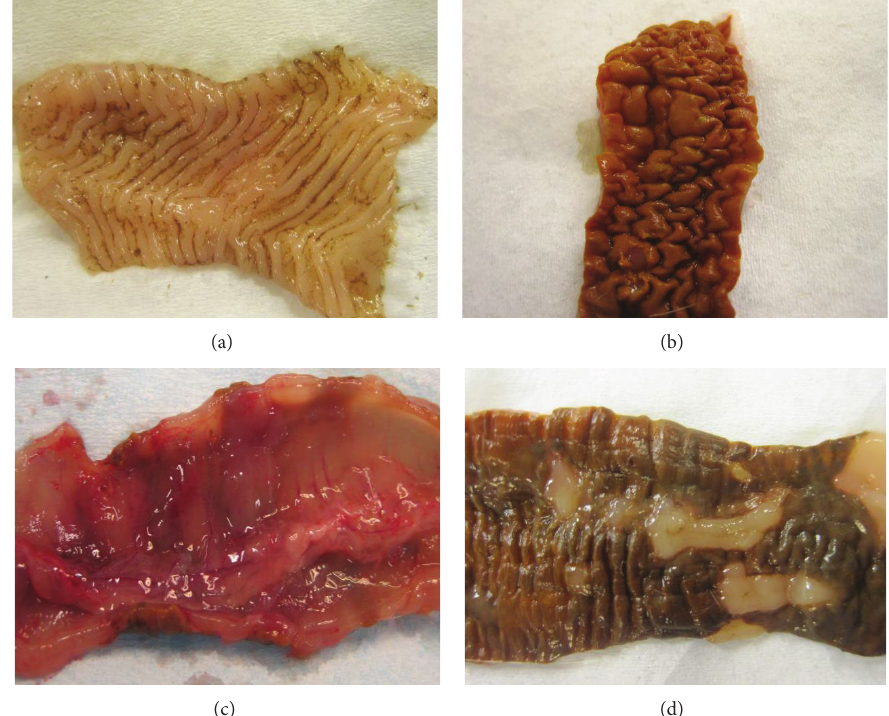
Figure 5: Macroscopic appearances of the colons of control rats ((a) and (b)), a rat treated with DTCM-G (c), and a rat treated with DHMEQ (d).